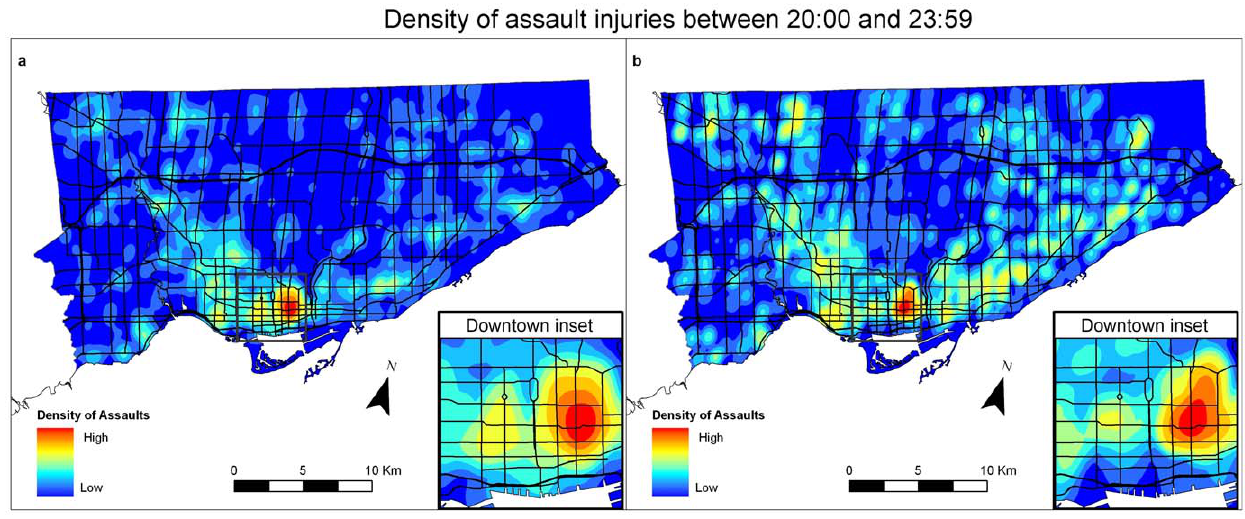
Figure 3. Assault injury densities in Toronto using data aggregated for 4 hours (20:00 and 23:59 hrs). Figure 3a: Density of assault injuries between 20:00 and 23:59 for EMS dataset. Figure 3b: Density of assault injuries between 20:00 and 23:59 for NACRS dataset.